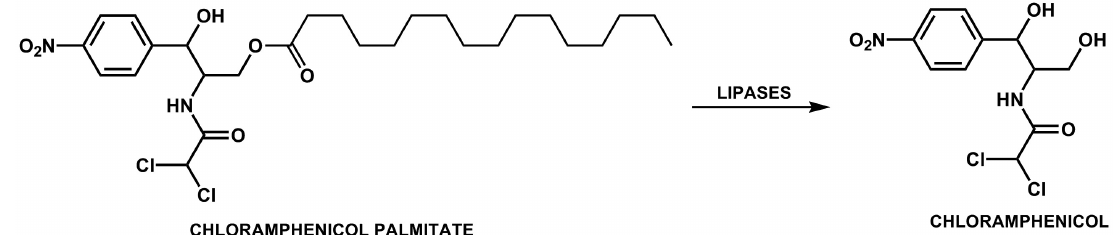
FIGURE 23 - Enzymatic conversion of the chloramphenicol palmitate into chloramphenicol, its active form. ceutical form for ophthalmic application,